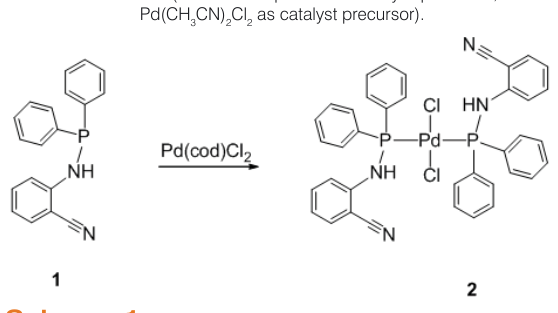
Figure 3. Catalytic system recycling using iodobenzene as sub- strate and TEM image of Pd NPs taken from the fourth run (Above: Complex 2 as catalyst precursor; Below: Pd(CH